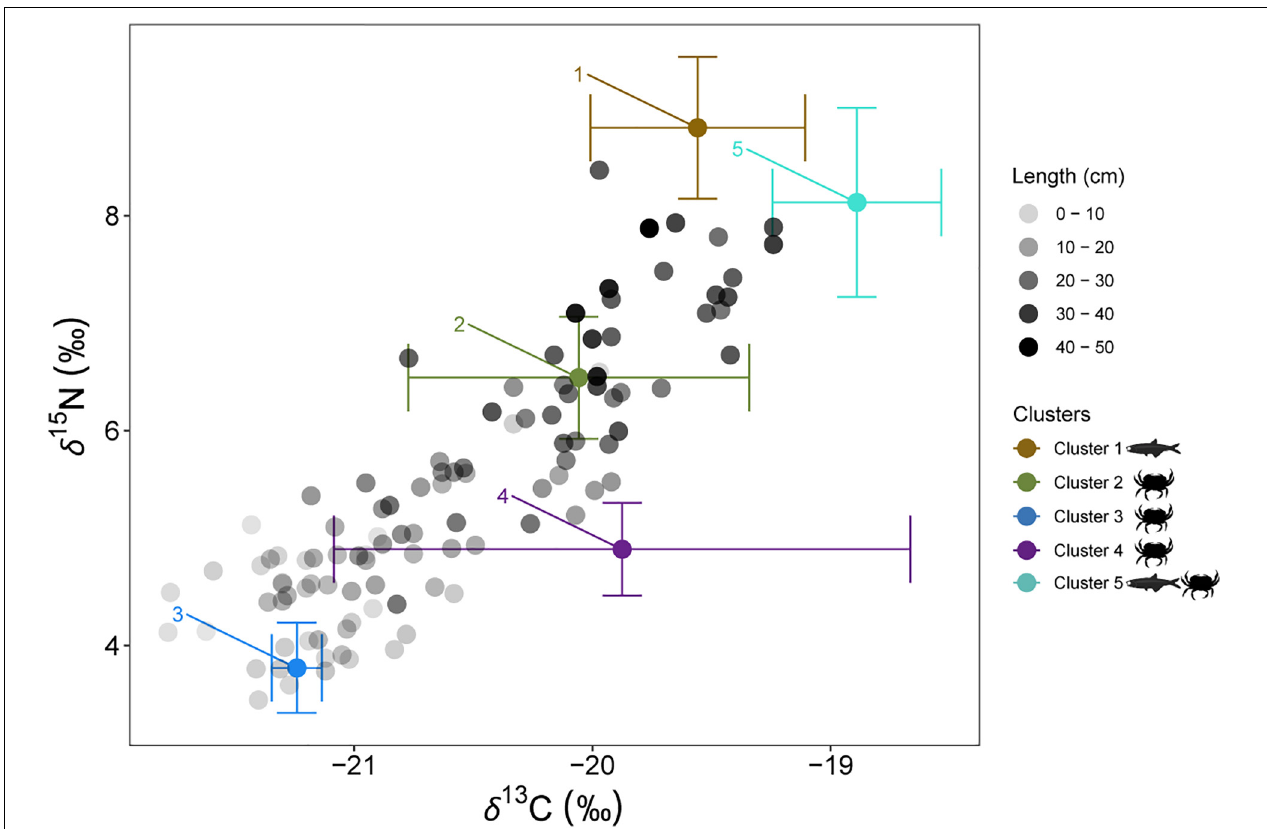
FIGURE 5 | Individual European hake δ 13 C and δ 15 N values and mean and standard deviation δ 13 C and δ 15 N values of the potential prey sources. Black shaded scale of European hake represents the body length of the individuals. In brown, Cluster 1 : Cepola macrophthalma, Boops boops, Spicara maena, Spicara smaris, Argentina sphyraena, Trisopterus minutus, Lepidopus caudatus, Sardina pilchardus, Maurolicus muelleri, Gadiculus argenteus and Micromesistius poutassou; in green, Cluster 2 : Chlorotocus crassicornis , Nematoscelis megalops and Phronima sedentaria ; in blue, Cluster 3 : Vibilia armata ; in violet, Cluster 4 : Anchialina agilis and Meganyctiphanes norvegica and in aquamarine, Cluster 5 : Engraulis encrasicolus, Plesionika heterocarpus, Sardinella aurita and Solenocera